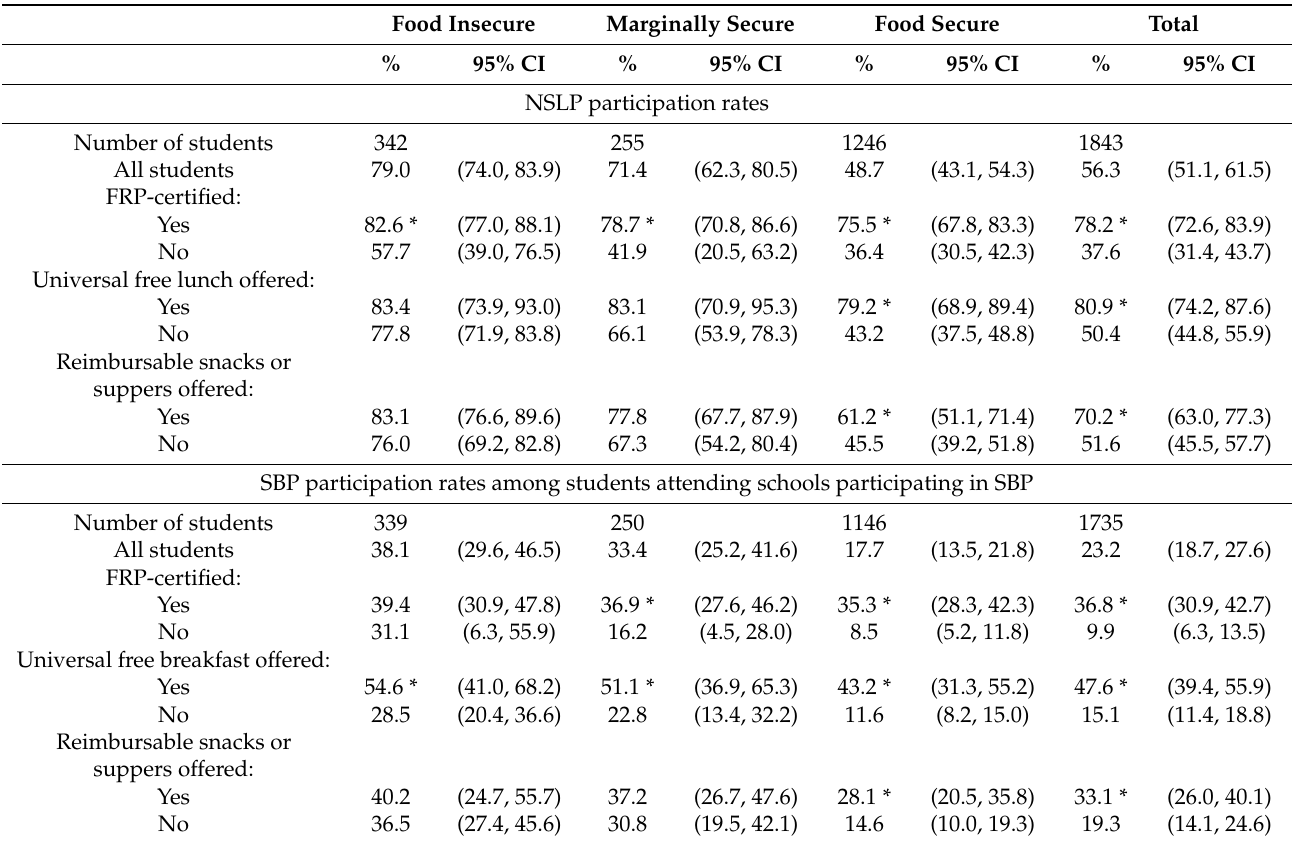
Table 3. Target day school meal participation rates by food security status and other student and school characteristics 1